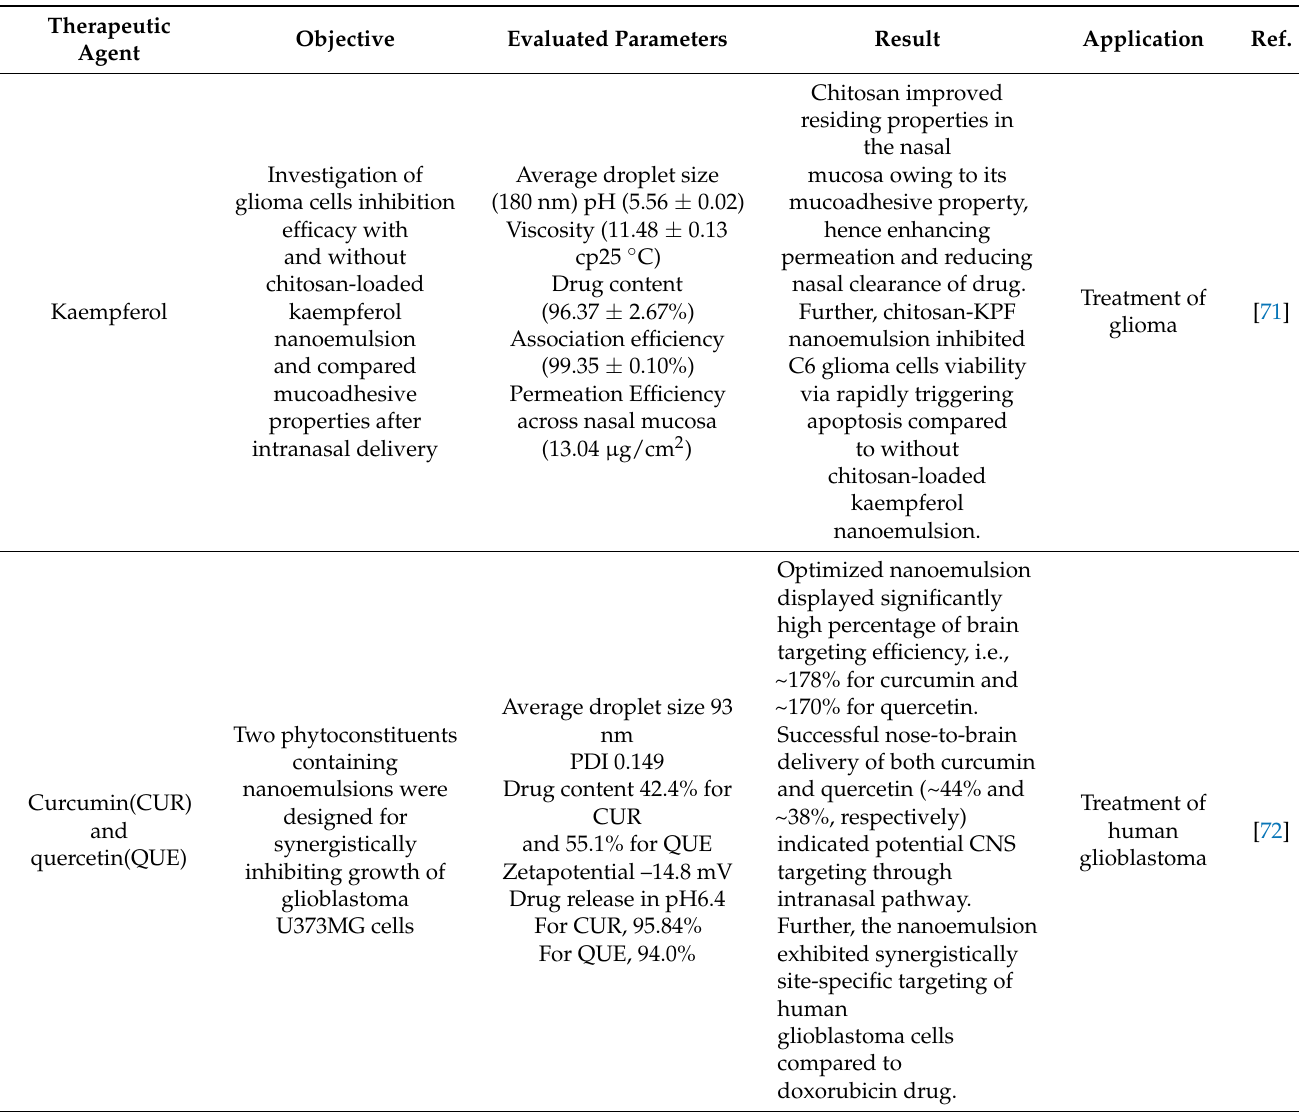
Table 3. Recently developed nanoemulsion for the treatment of brain glioblastoma (data collected for last 5